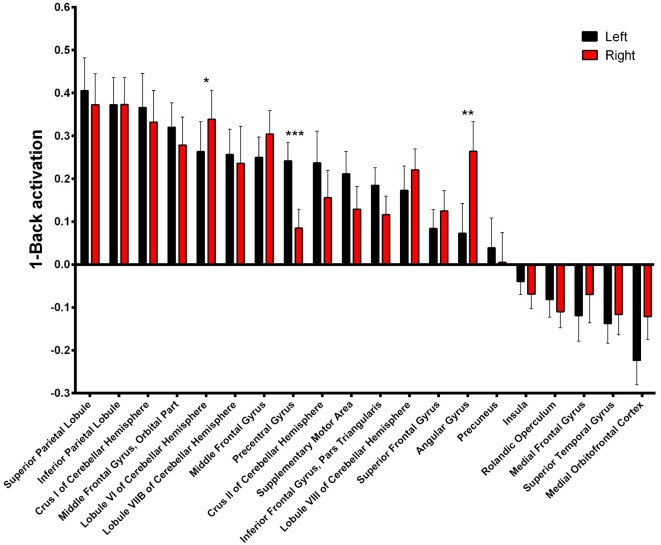
1-Back-related BOLD asymmetries. Comparison between left and right activations/deactivations during 1-Back performance. *α < 0.05, **α < 0.01, ***α < 0.001 in Bonferroni-corrected paired comparisons.